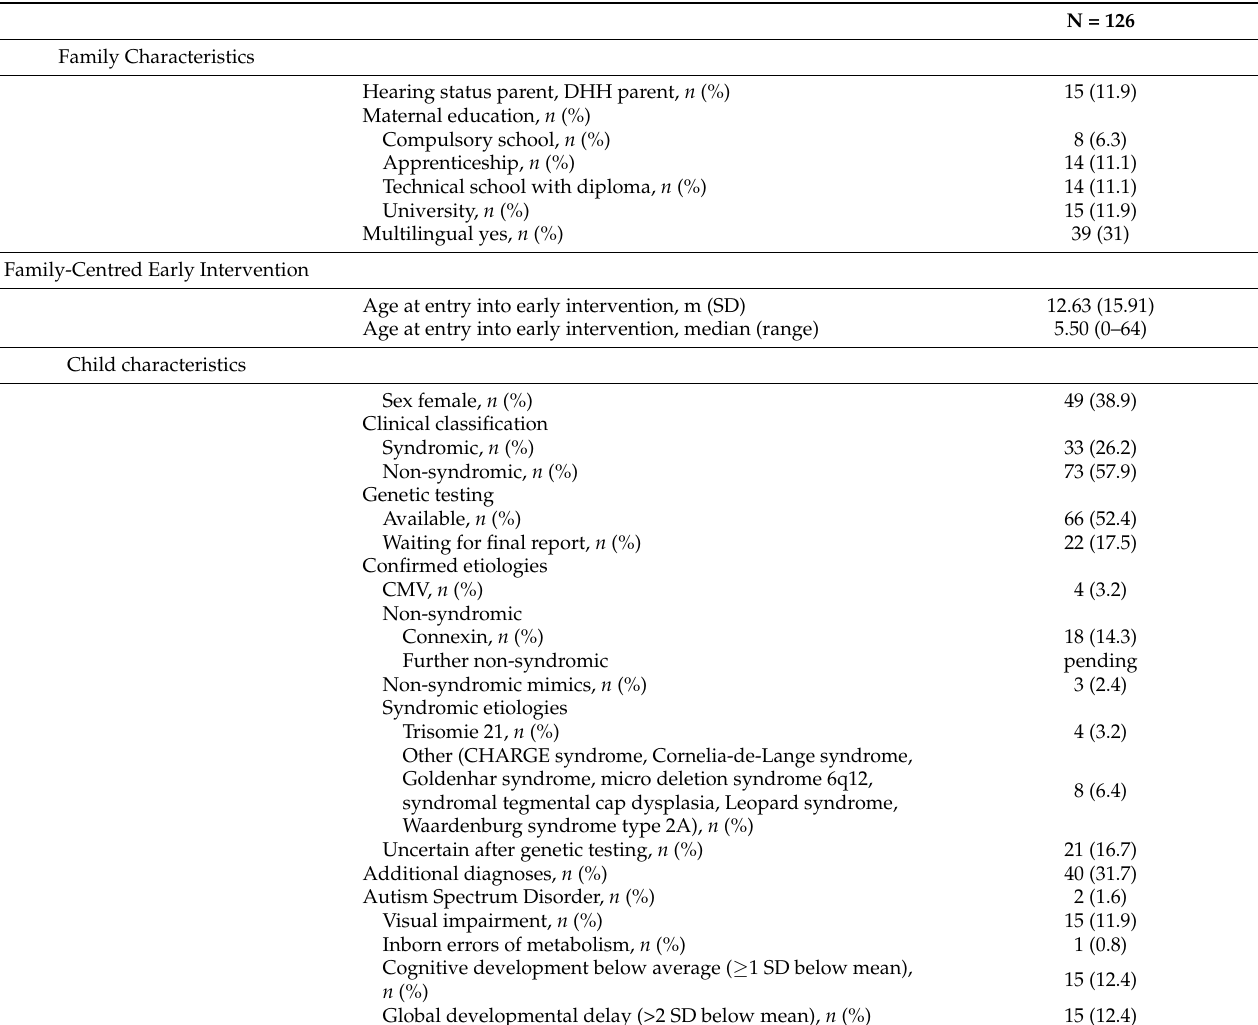
Table 2. Baseline characteristics of children who entered in the period 1 January 2020–30 April 2021.